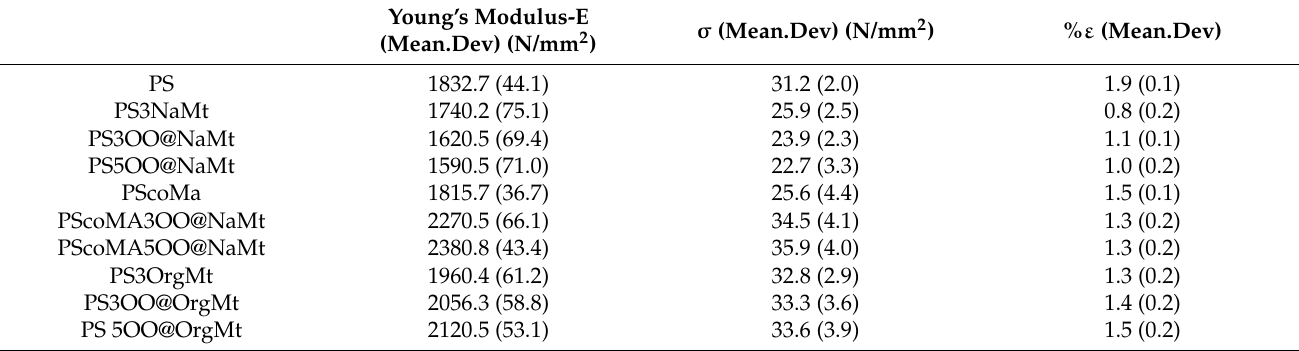
Figure 3. FTIR plots of all PS/ NaMt ( a ), PScoMANaMt ( b ), and PSOrgMt ( c ) films. Table 2. Young’s Modulus (E), tensile strength ( σ uts ), and elongation at break ( ε b ) values of all tested